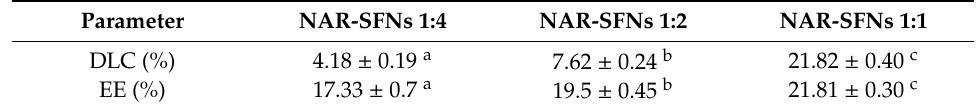
Table 2. Drug loading content (DLC) and entrapment e ffi ciency (EE) of the NAR-SFNs 1:4,